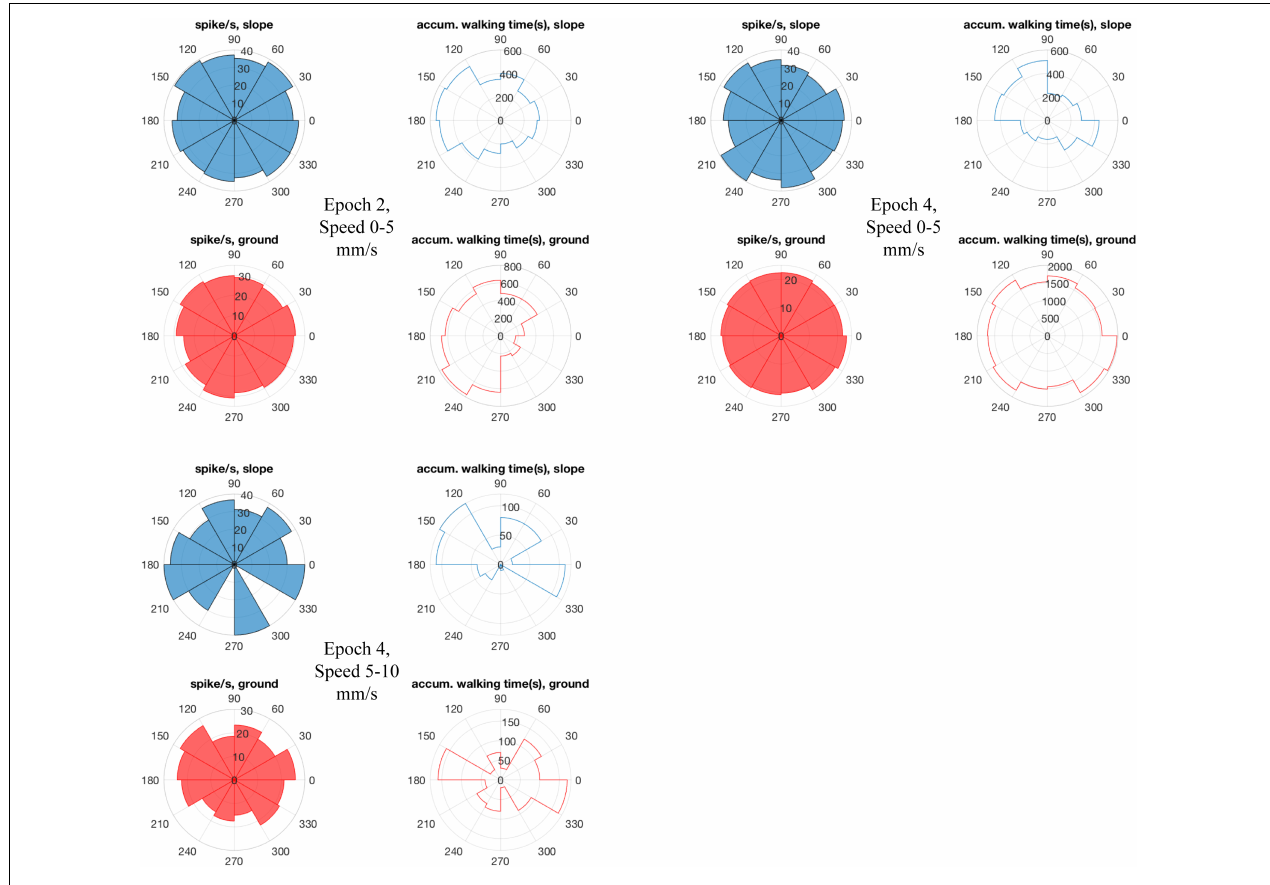
FIGURE 10 | Bee 140409 walking directions and neuro-activity in * marked epochs of Figure 8 . The 360 ◦ is binned into 12 sectors (i.e., 30 ◦ /sector). Blue sectors: slope, red: ground. Filled sectors: spikes/second; unfilled: accumulated walking time. Data of other units are in Supplementary Figure S7